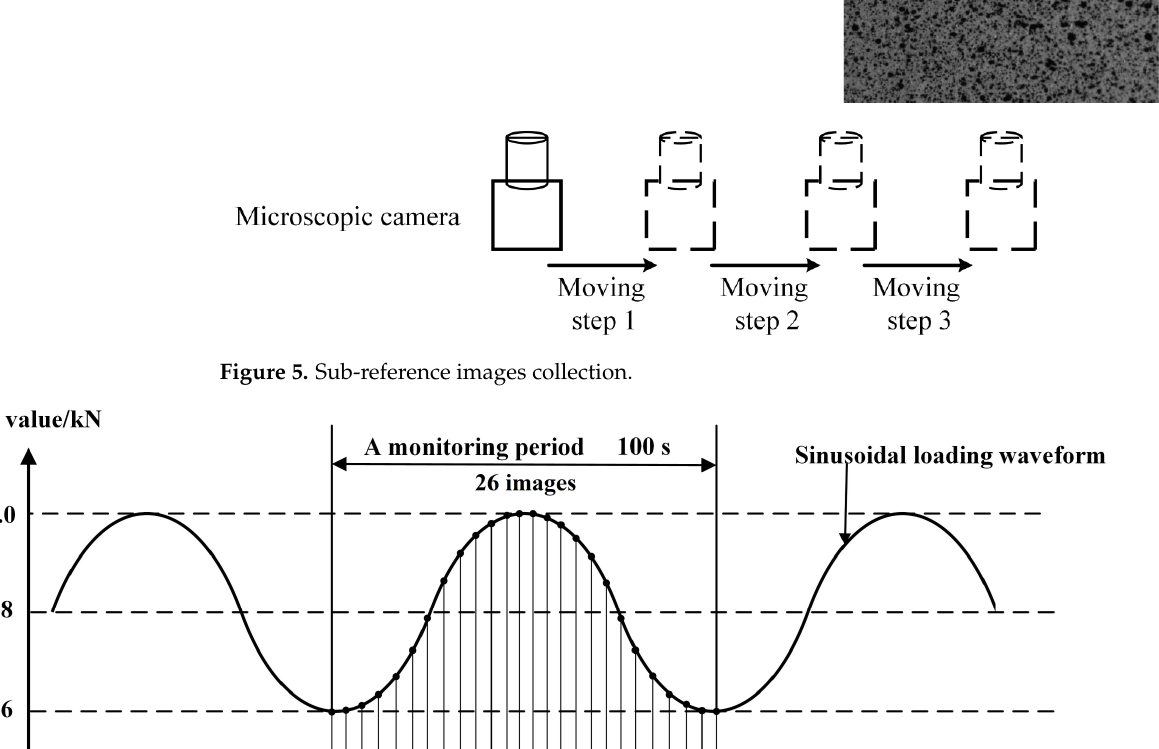
Figure 7. Maximum load point images corresponding to different cycle numbers: ( a ) Speckle images; ( b ) global crack images. 3. In Situ Measurement Algorithms of CPZ and Internal Response at the Crack Tip 3.1. Measurement Algorithms of CPZ and Internal Response Near the Crack Tip Based on DIC The measurement flow of CPZ based on DIC is shown in Figure 8, in which the core technologies are DIC and the load–strain curve characteristic judgment algorithm. In or- der to calculate the in situ strain field at the different crack lengths [29], it was necessary to use the image stitching and matching algorithm to obtain the full-field reference image and the reference images corresponding to the target images, as shown in Figure 8. Our previous work [29] introduced the specific implementation and the accuracy verification details of the sub-reference image stitching and target image matching algorithm. Finally, the target images and reference sub-images were used for DIC calculation to obtain the